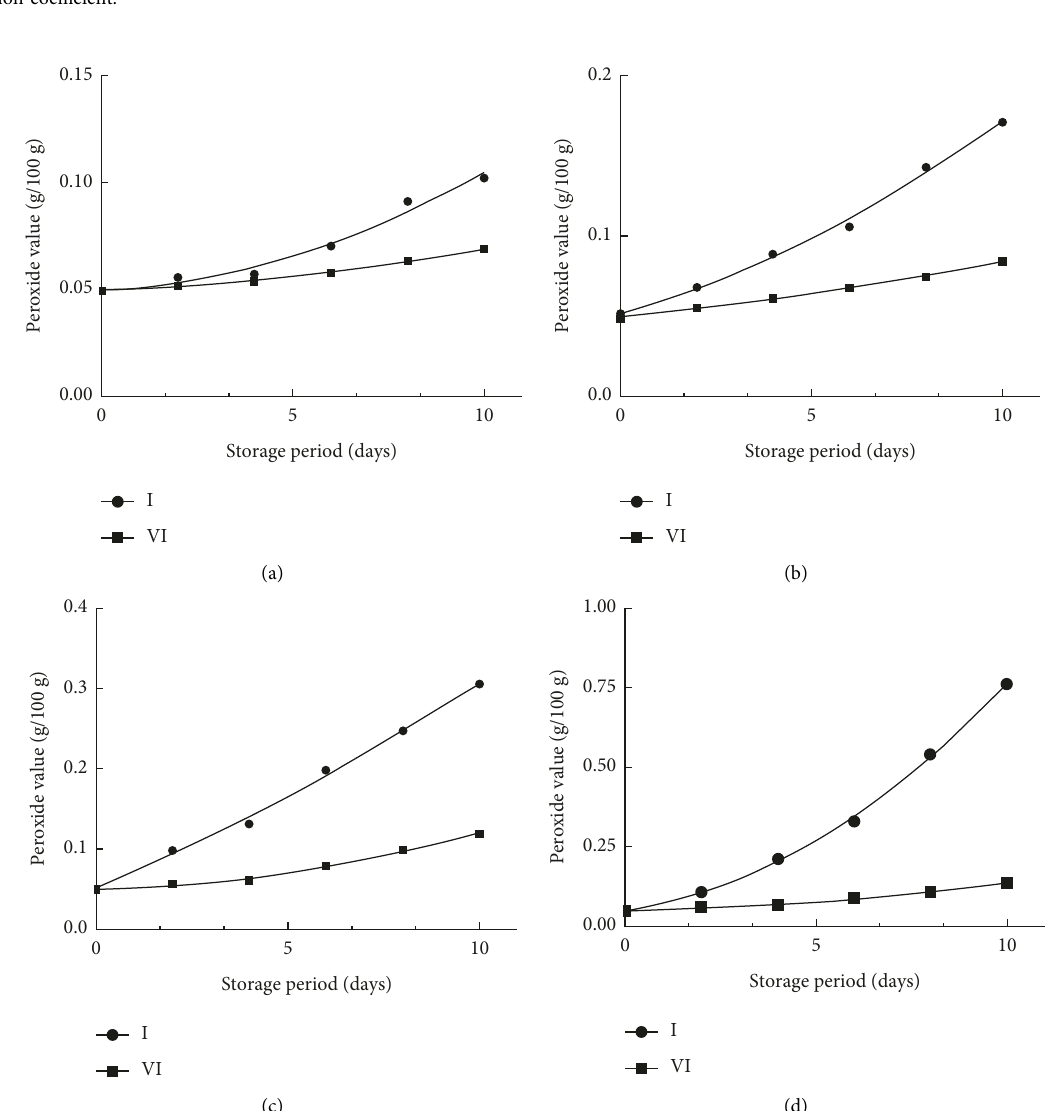
Figure 2: The first-stage dynamic model fitting of POV changes in peanut oil with addition of Group I or Group VI antioxidants compounds during the different storage period at 45 ° C (a), 50 ° C (b), 55 ° C (c), and 60 ° C (d). POV, Peroxide